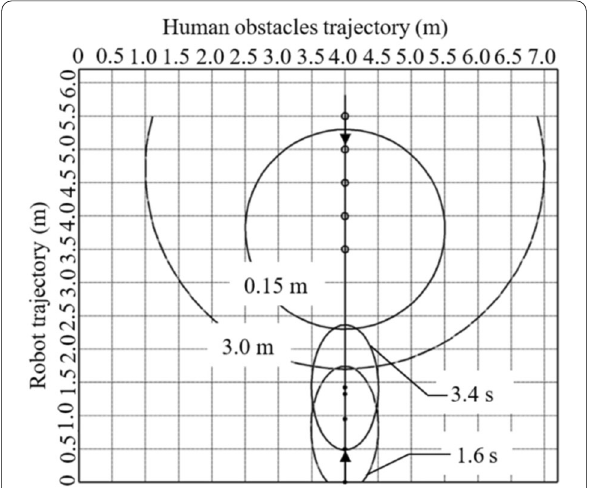
Figure 15 Encountering behavior pattern simulation